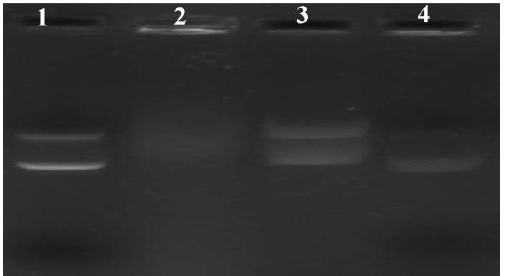
Figure 6. Stability of PLA-PEG-PLL NPs/DNA complexes (N/P 15:1) in 10% human plasma. Lane 1: Naked DNA; Lane 2: Naked DNA incubated with human plasma for 2 h; Lane 3: NPs/DNA complex incubated with human plasma for 2 h; Lane 4: NPs/DNA complex extracted with 1%